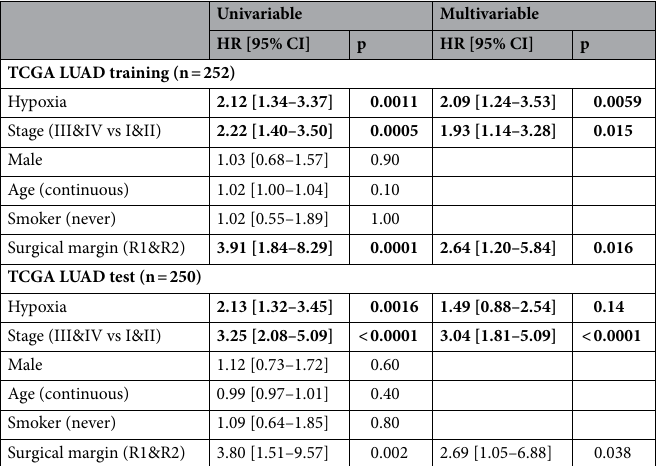
Univariable Multivariable HR [95% CI] p HR [95% CI]